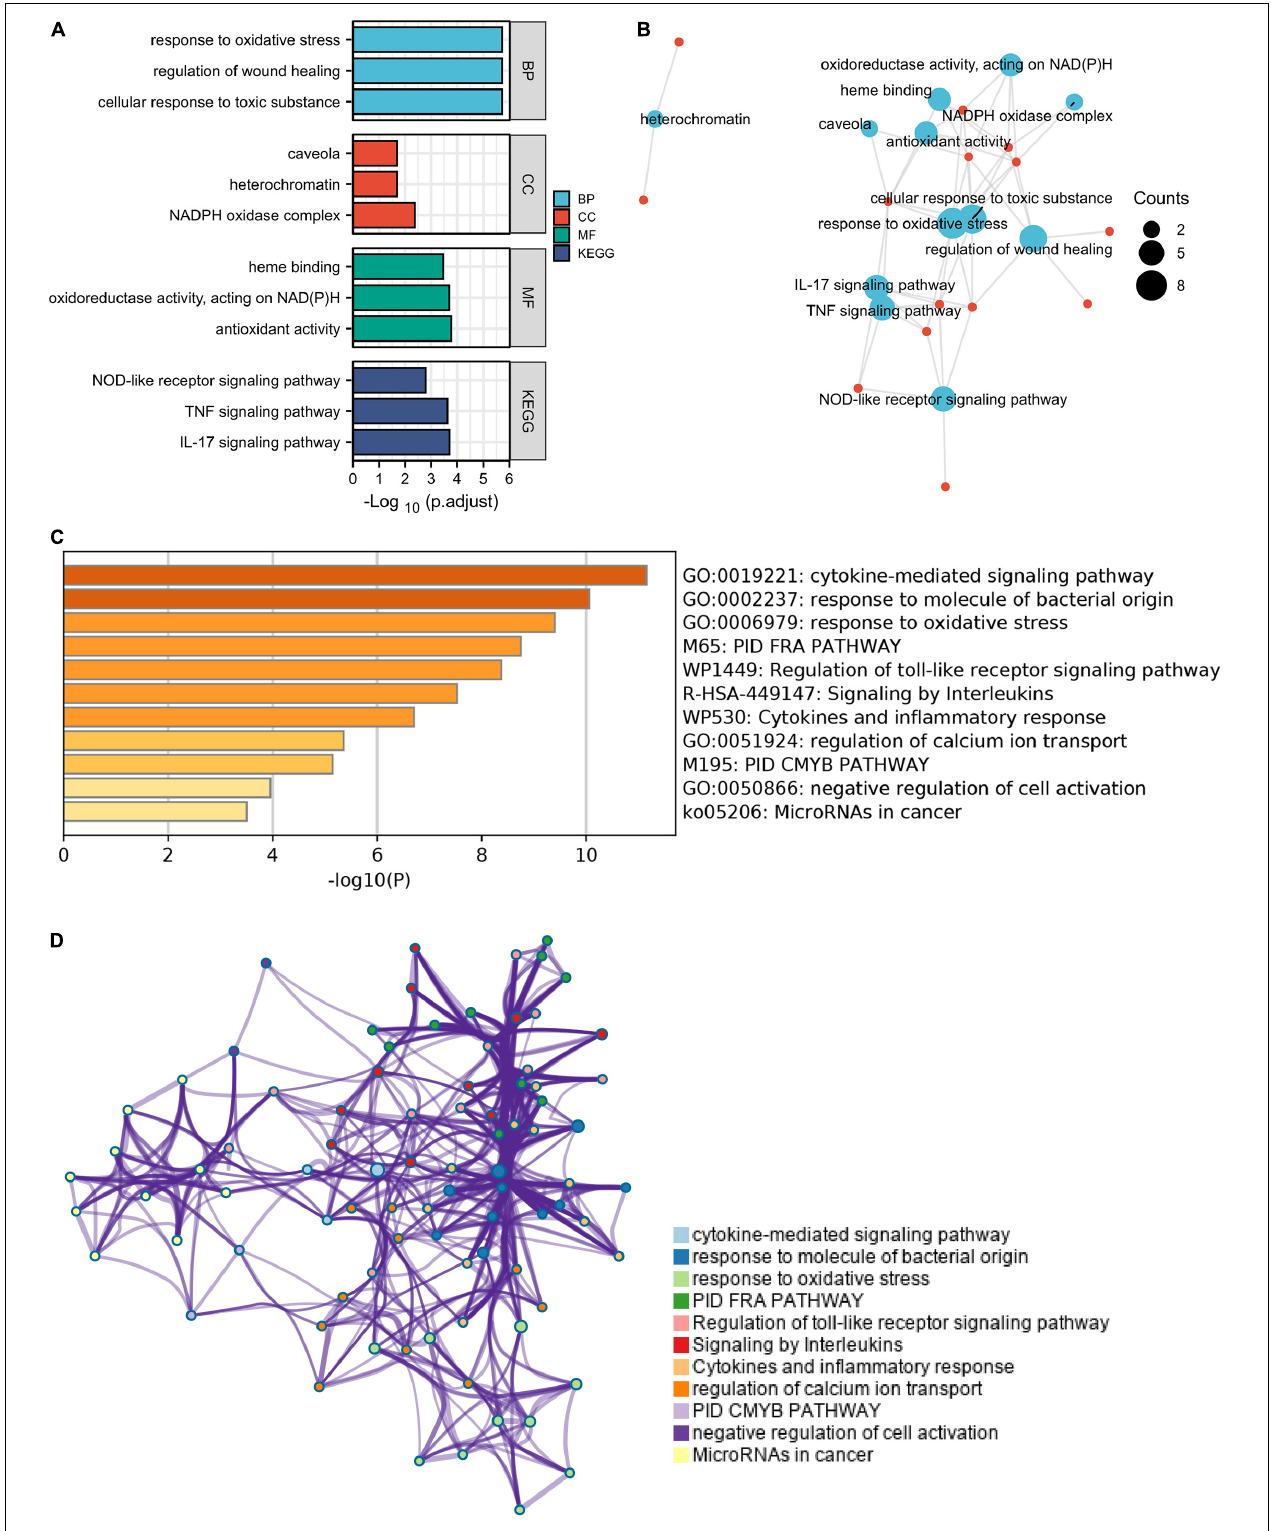
FIGURE 7 | The enrichment pathway analysis of ferroptosis- and autophagy-related hub genes. (A) The significant GO and KEGG pathways enriched by ferroptosis- and autophagy-related hub genes using Xiantao Website. (B) The pathways network of the hub genes using the Xiantao Website. (C) The enrichment pathway analysis of the hub genes using Metascape. (D) The pathways network of the hub genes using Metascape.